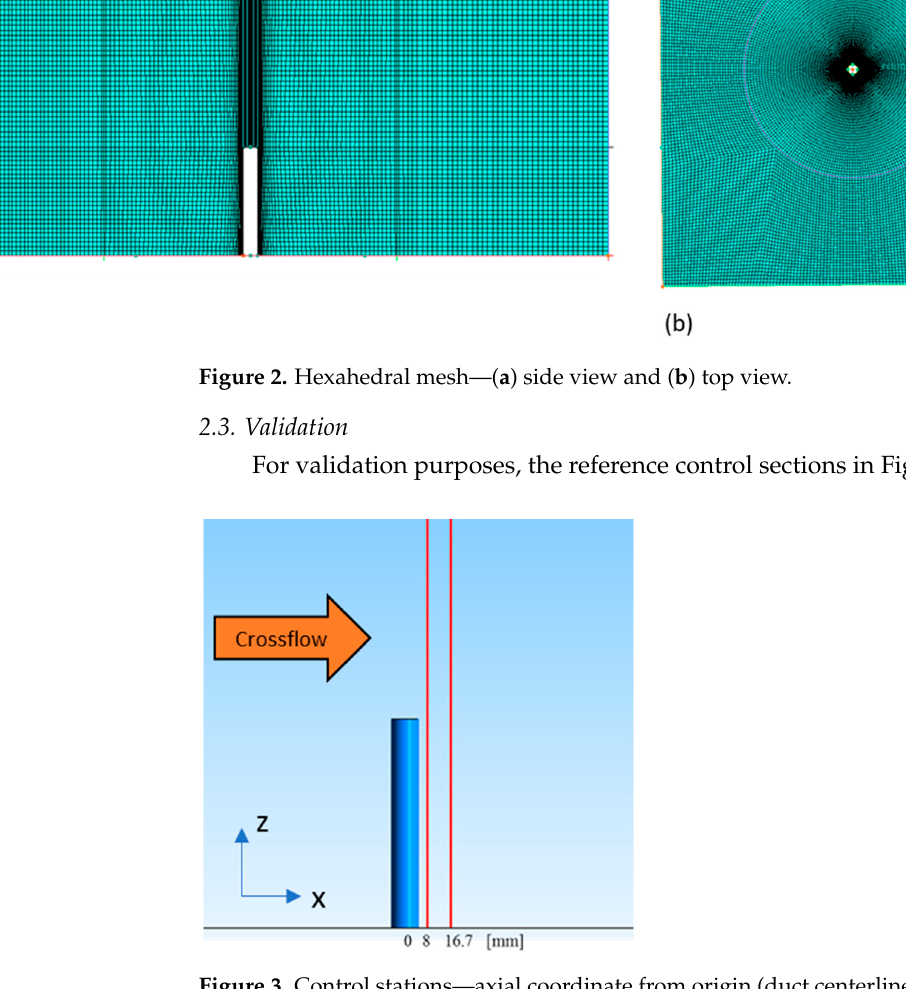
Figure 2. Hexahedral mesh—( a ) side view and ( b ) top view.